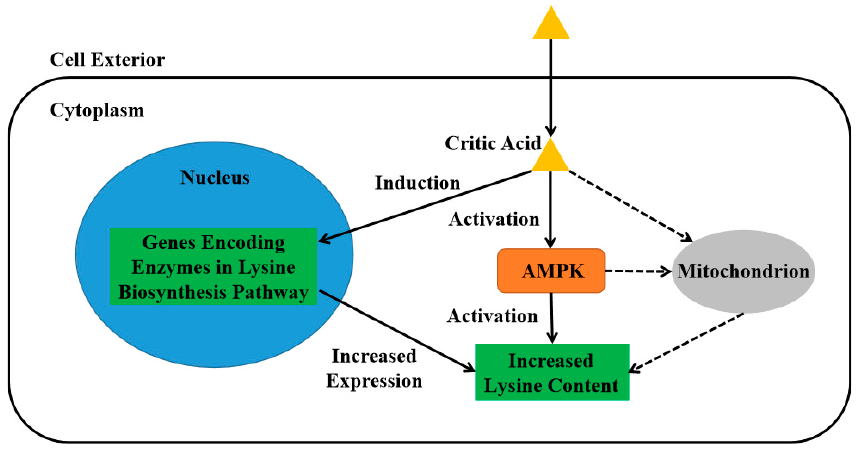
Figure 7. Effects of citric acid induction on lysine biosynthesis in Flammulina filiformis . Citric acid treatment induces the upregulation of expression of AMPK and genes encoding enzymes in the lysine biosynthesis pathway. AMPK is further activated by the increase in phosphorylation level. Both the upregulation of synthase genes and the activation of AMPK together increase the lysine content in F. filiformis . Dotted lines represent the hypothetical series of events not involved in this